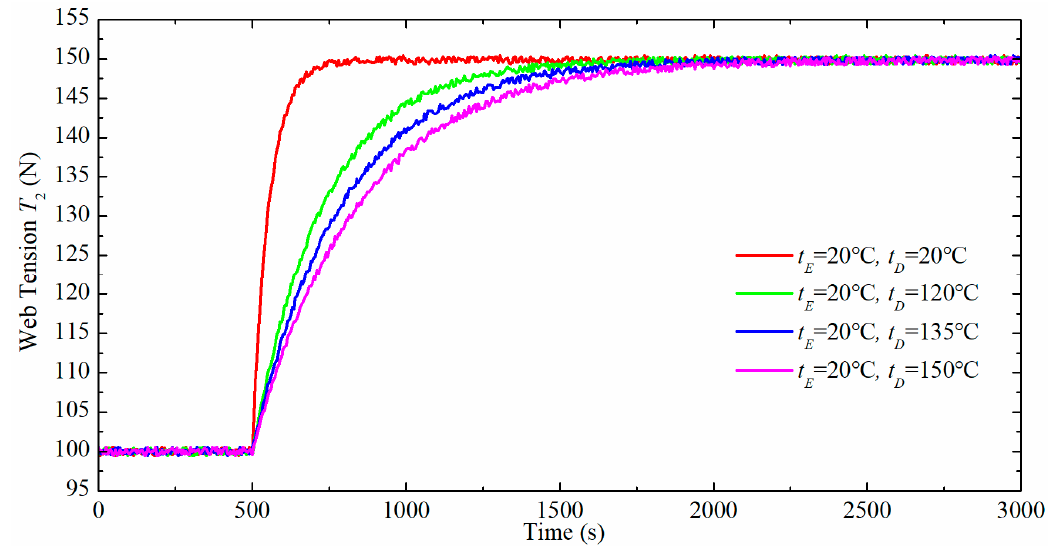
Figure 9. The responses of the tension T 2 ( t ) as v 2 ( t ) has step changes at different drying temperatures in experiments.